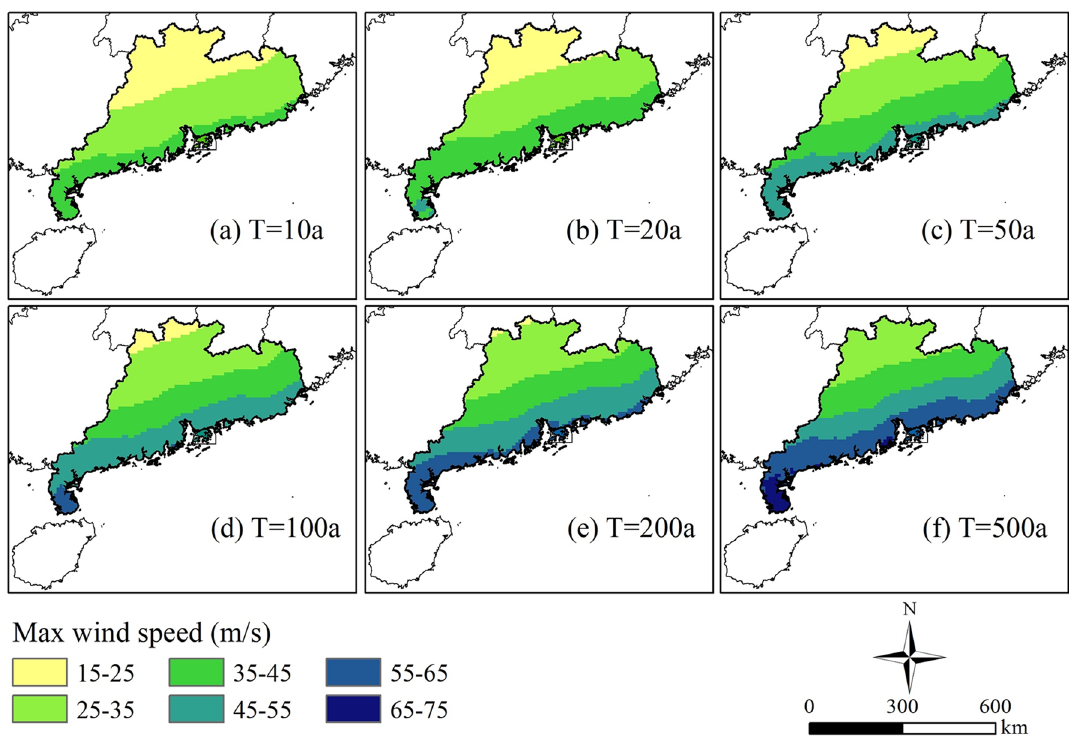
Fig. 7 Spatial distribution of the extreme wind speed in six return periods of 10, 20, 50, 100, 200, and 500 years in Guangdong Province, South China